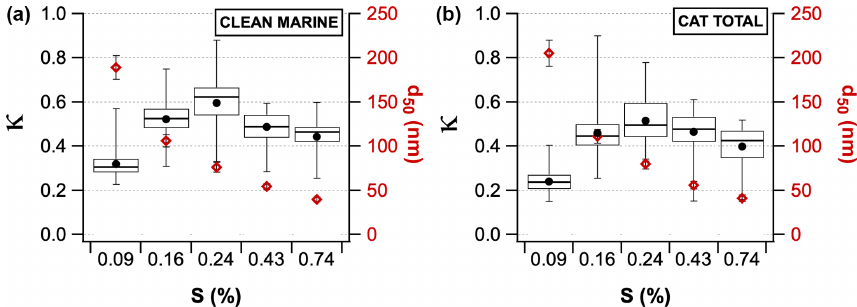
Figure 6. Hygroscopicity parameter κ ( a ; box plots) and corresponding mean diameter at which 50% of the particles in an aerosol population activate as CCN at a particular S , also called the critical diameter “ d 50 ” ( b ; red markers) for the investigated supersaturations ( S ). Whiskers on “ d 50 ” markers represent standard deviation values of “ d 50 ”. Black dots in the box plot indicate κ mean values. Boxes represent the upper quartile, median, and lower quartile κ values at each S . Whiskers represent the upper and lower limits of κ at each S .